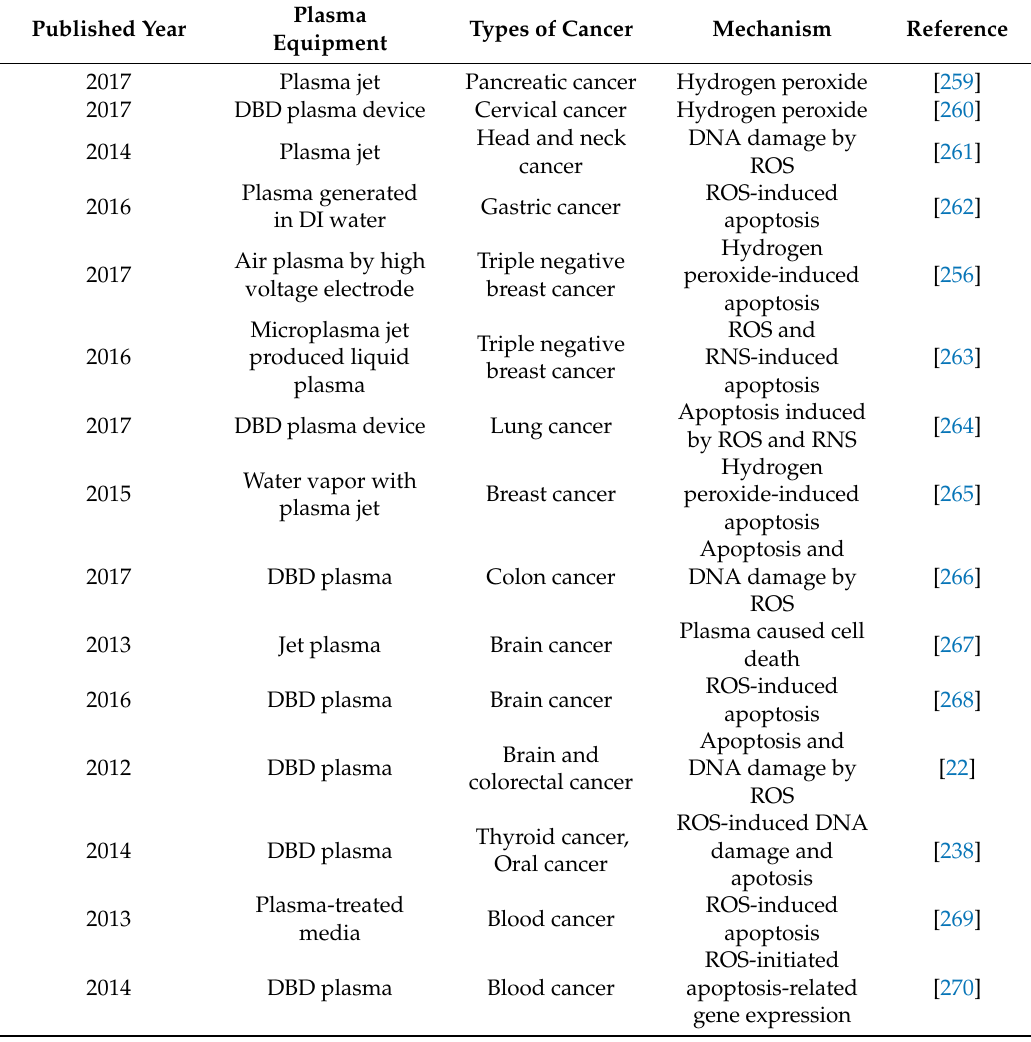
Table 3. List of plasma instruments and methods used in di ff erent types of cancer with their